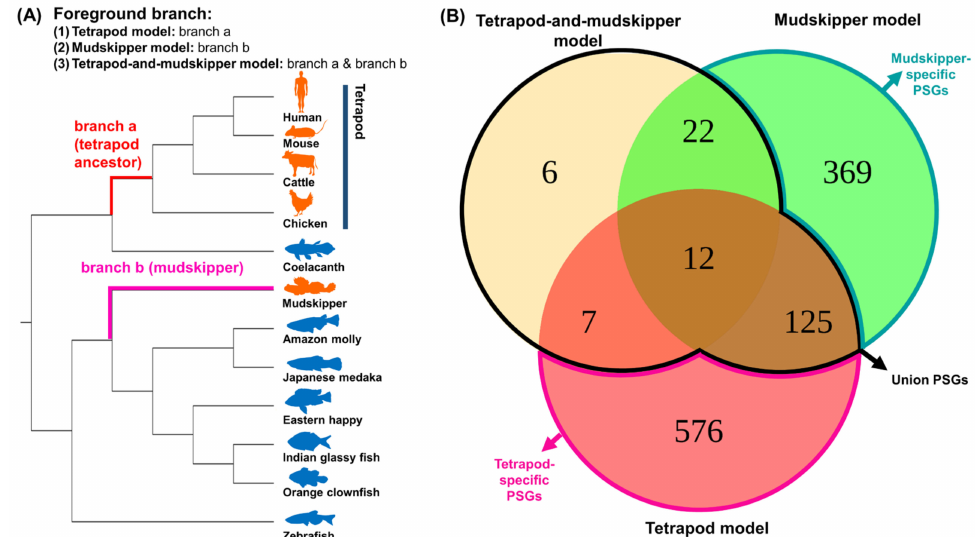
Figure 1. Different evolutionary models assuming positive selection on land-adapting lineages and the number of positively selected genes (PSGs). ( A ) Phylogeny was downloaded from TimeTree database [35]. Orange and blue indicate land- adapting and fully aquatic species, respectively. Red indicates the common ancestor branch of terrestrial tetrapod species and pink indicates mudskipper branch. For the branch-site test, three different alternative model A were tested by changing foreground branch (the branch under potential positive selection) to branch a (tetrapod model), branch b (mudskipper model), and both branches (tetrapod-and-mudskipper model). ( B ) The number of PSGs detected under threshold (FDR < 0.1, 2 ∆ L > 0, and ω 2 > 1). Red, green, and yellow backgrounds indicate PSGs in tetrapod model, mudskipper model, and tetrapod-and-mudskipper model, respectively. Pink, green, and black lines indicate tetrapod-specific, mudskipper-specific, and union PSGs,